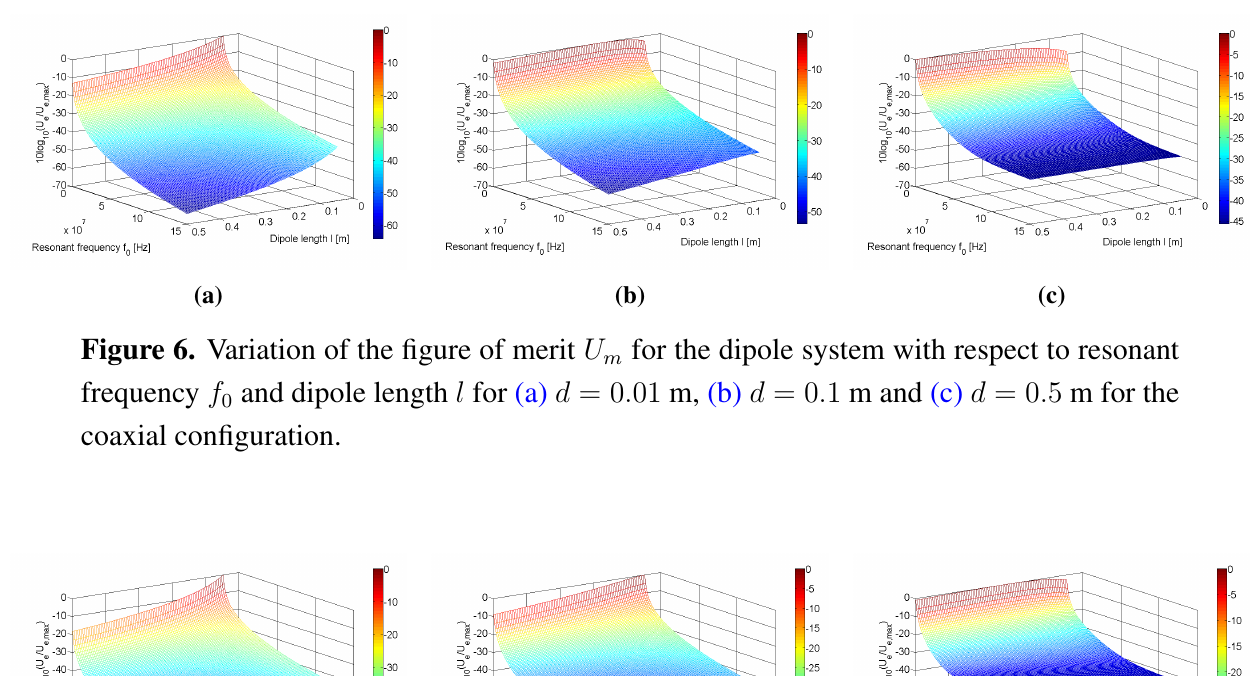
for the dipole system with respect to resonant e